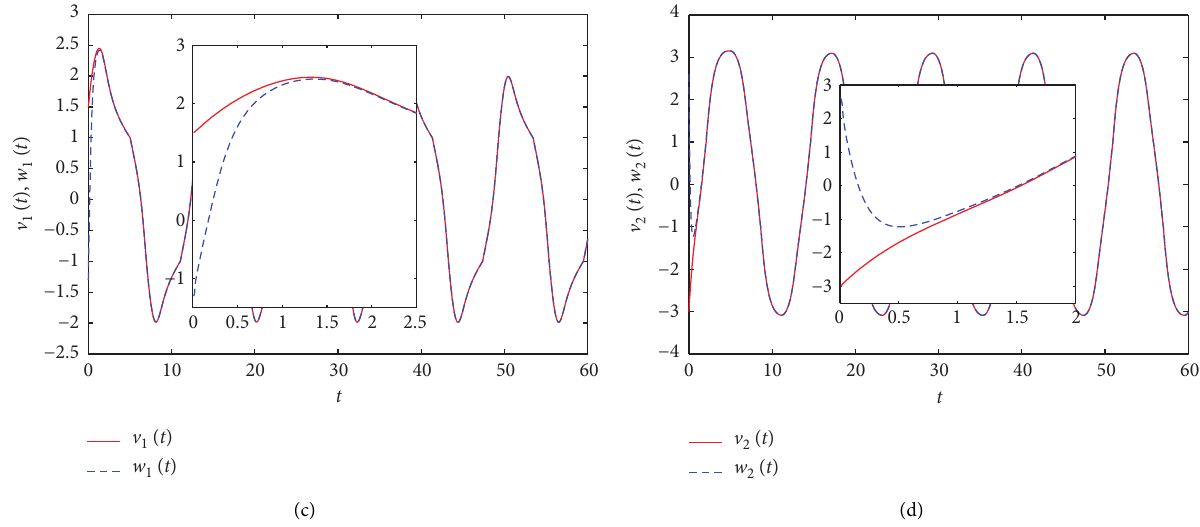
Figure 4: The chaotic behaviors, error and state trajectories of the derive FOMNN (46), and the response FOMNN (8) with the state feedback controller u